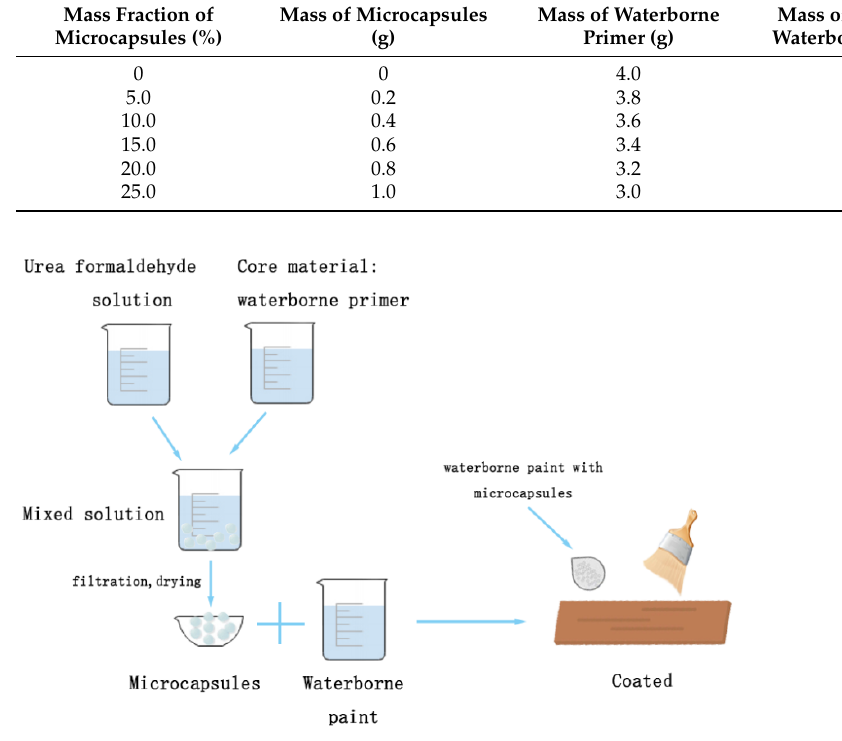
Figure 1. Flow chart of the experiment.